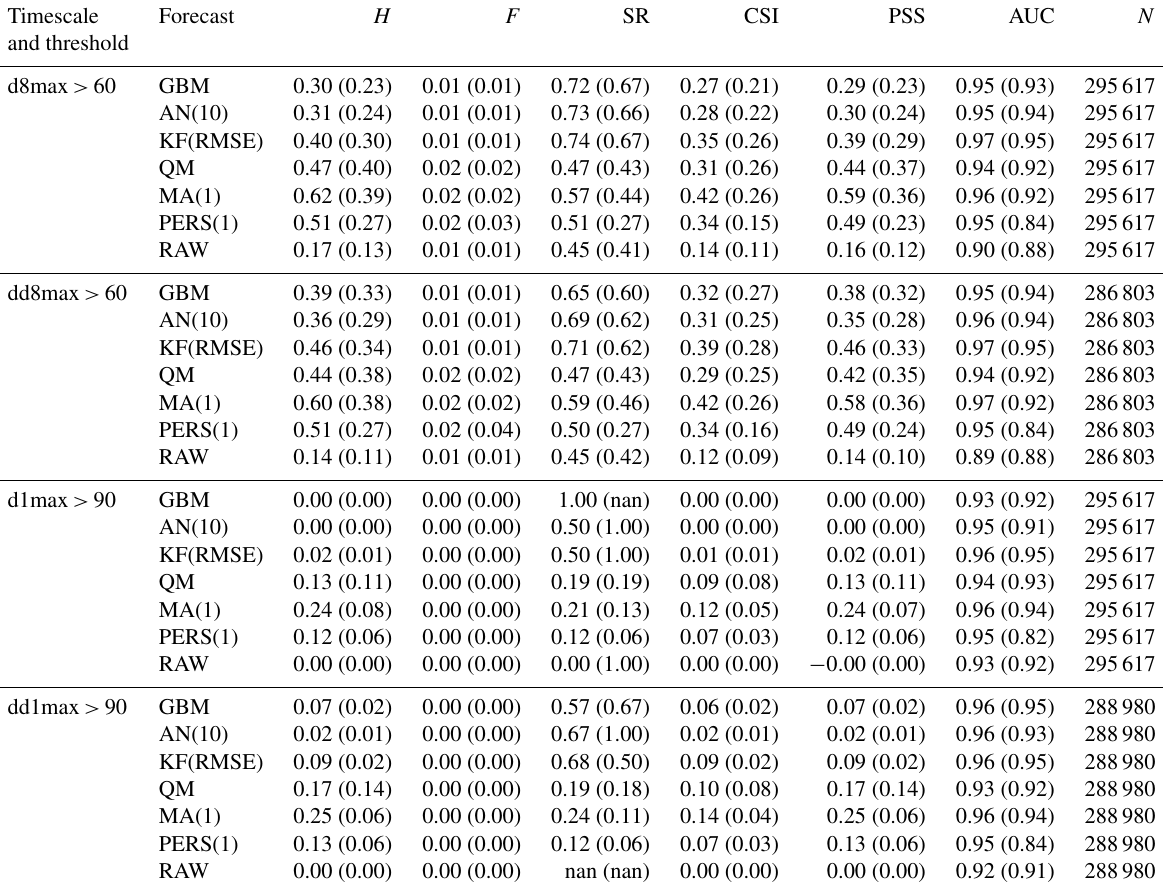
Table 2. Evaluation of the different forecast methods on categorical metrics, at D + 1 (and D + 4 in parentheses), for both target and information thresholds. Timescale and